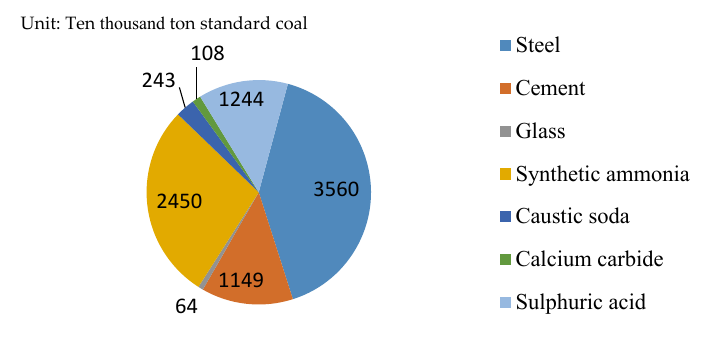
Figure 2. Utilization of waste heat resources during 11th